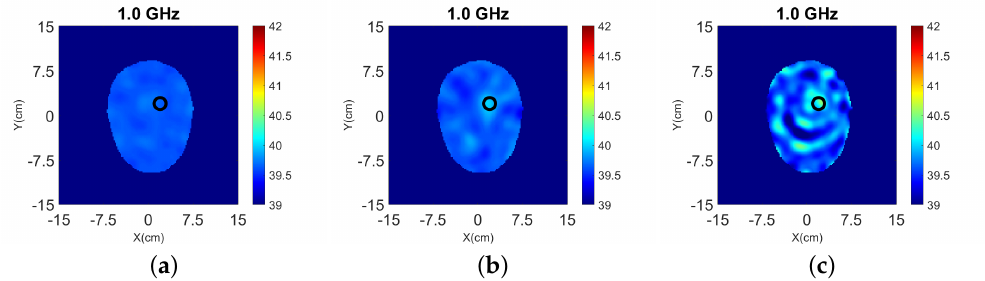
Figure 18. 2-D Reconstructions of (cid:60) ( ε r ) of Case III.2 for the x-y slice at 1.0 GHz using data from the: ( a ) bottom ring, ( b ) top ring, and ( c ) both rings. The headband of Figure 14 (with the addition of absorbing material) is used to obtain the data.